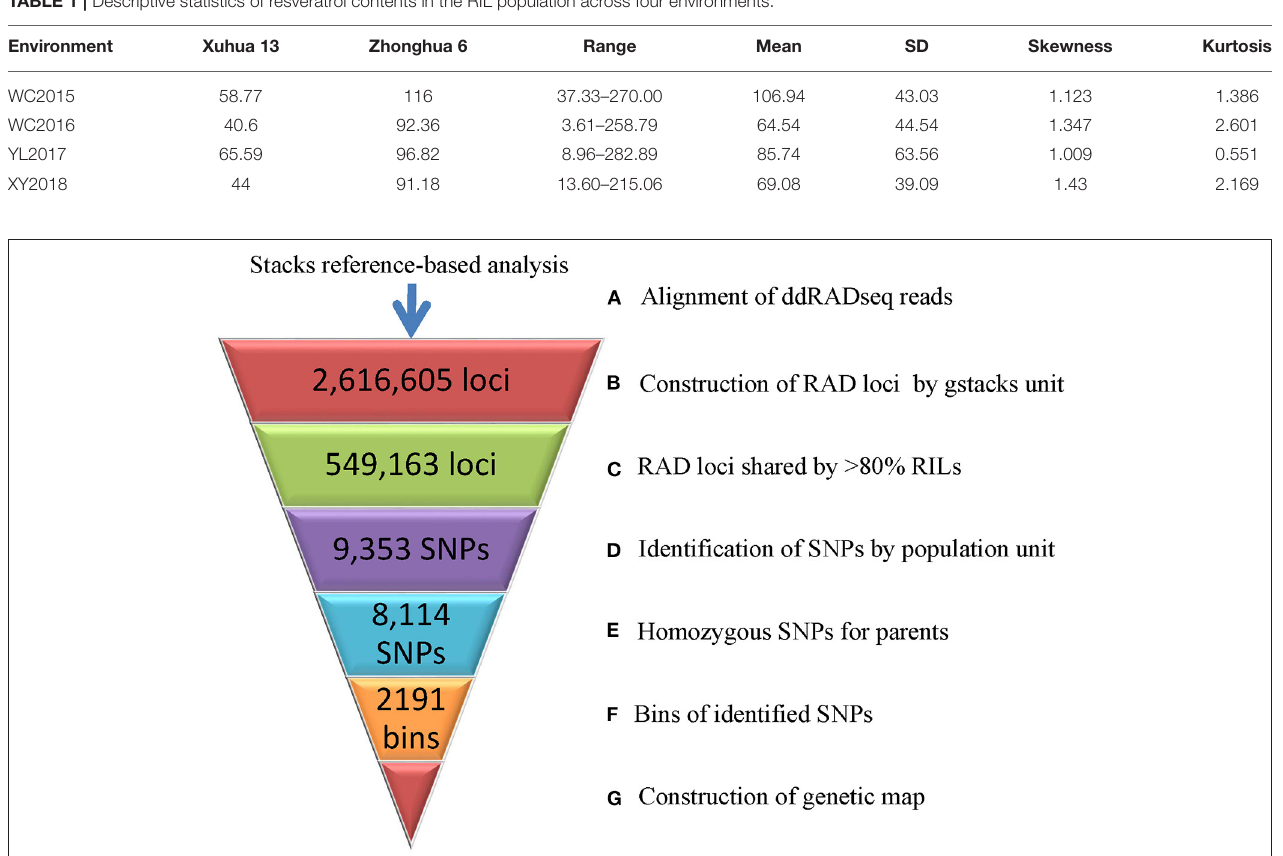
FIGURE 2 | Genotyping of the RIL population based on ddRADseq data.